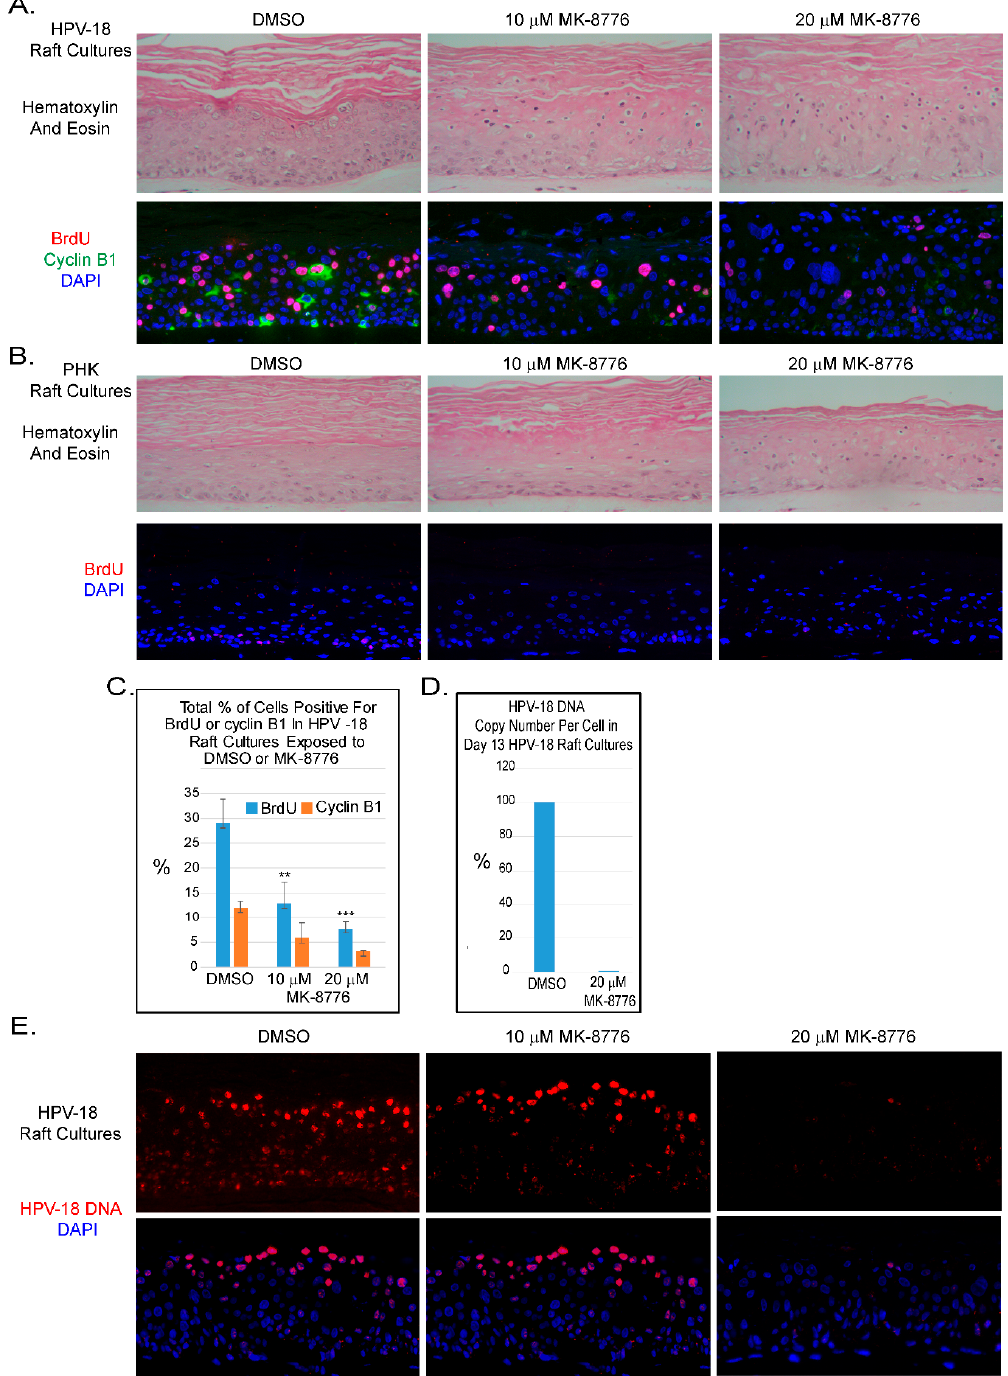
Figure 1. Chk1 inhibitor, MK-8776, reduces host DNA replication and abrogates productive amplification of human papillomavirus (HPV)-18 in raft cultures. ( A ) Four micron tissue sections of HPV-18 raft cultures exposed to DMSO or 10 and 20 µM MK-8776 from days 7 to 12. Upper row, hematoxylin and eosin staining, showing cytotoxic effects, evident from condensed nuclei in upper differentiated strata. Cells were enlarged at the higher MK-8776 treated cultures. Lower row, dual immunofluorescence (IF) assay to detect BrdU incorporation (red) and cytoplasmic cyclin B1 accumulation (green). ( B ) Four micron tissue sections of uninfected PHK raft cultures exposed to DMSO or 10 and 20 µ M MK-8776 from days 7 to 12. Upper row, H&E staining. Cytotoxicity was